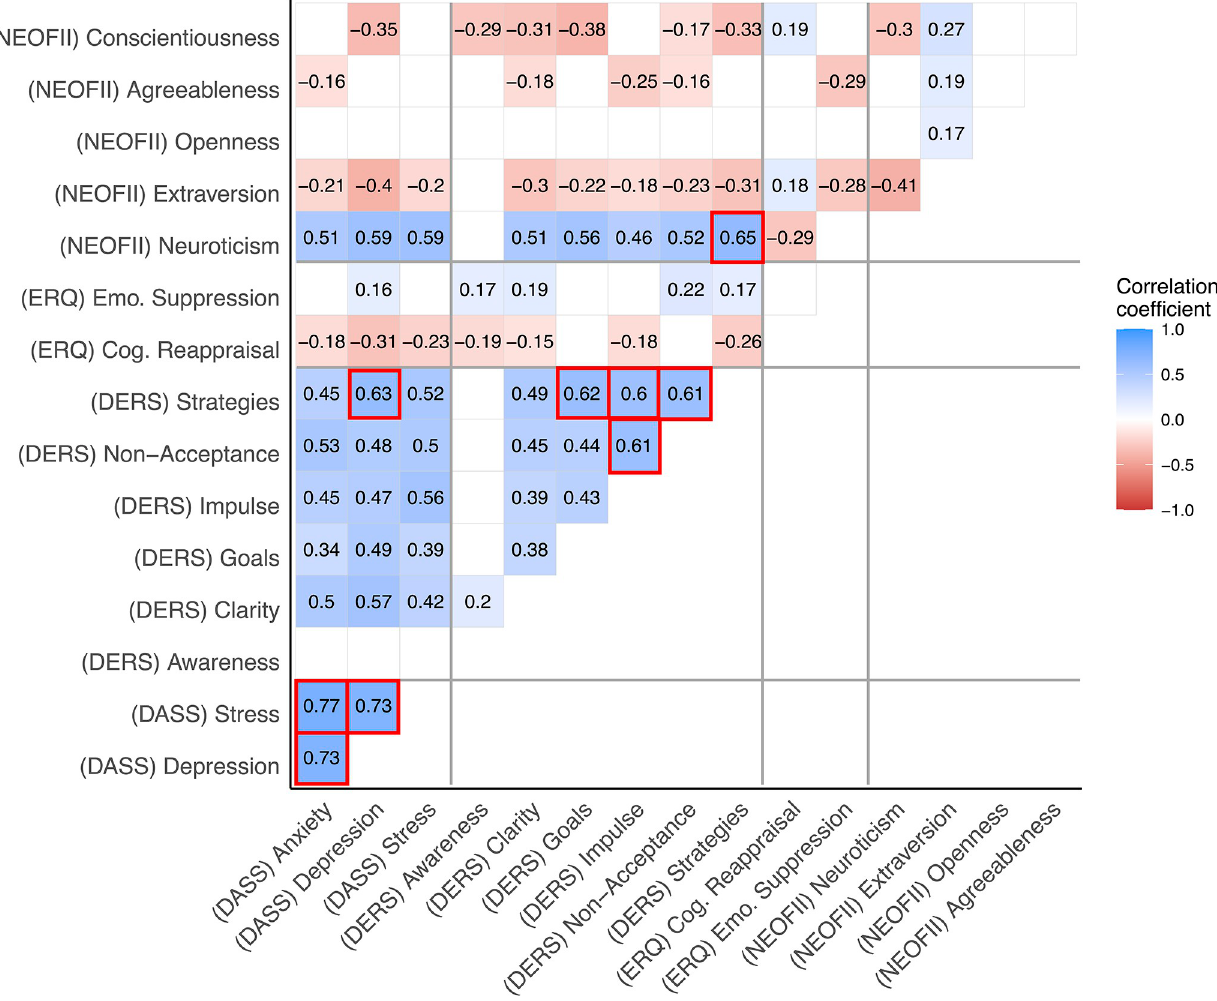
Fig 2. Pearson correlation on psychological symptoms, personality traits and emotional regulation skills at T0. N = 180. Only significant results (p < .05) are shown. Correlations > are shown inside of a red square.